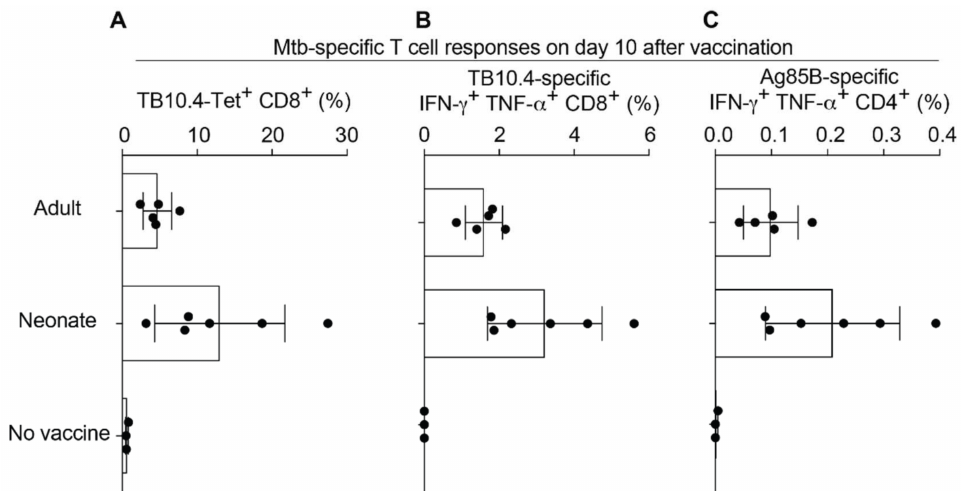
Figure 3. Neonatal mice mount robust CD8 and CD4 T cell responses to rLCMV vaccination. We immunized 1-week-old C57BL/6 mice s.c. with 10 5 PFU of rLCMV and analyzed T cell